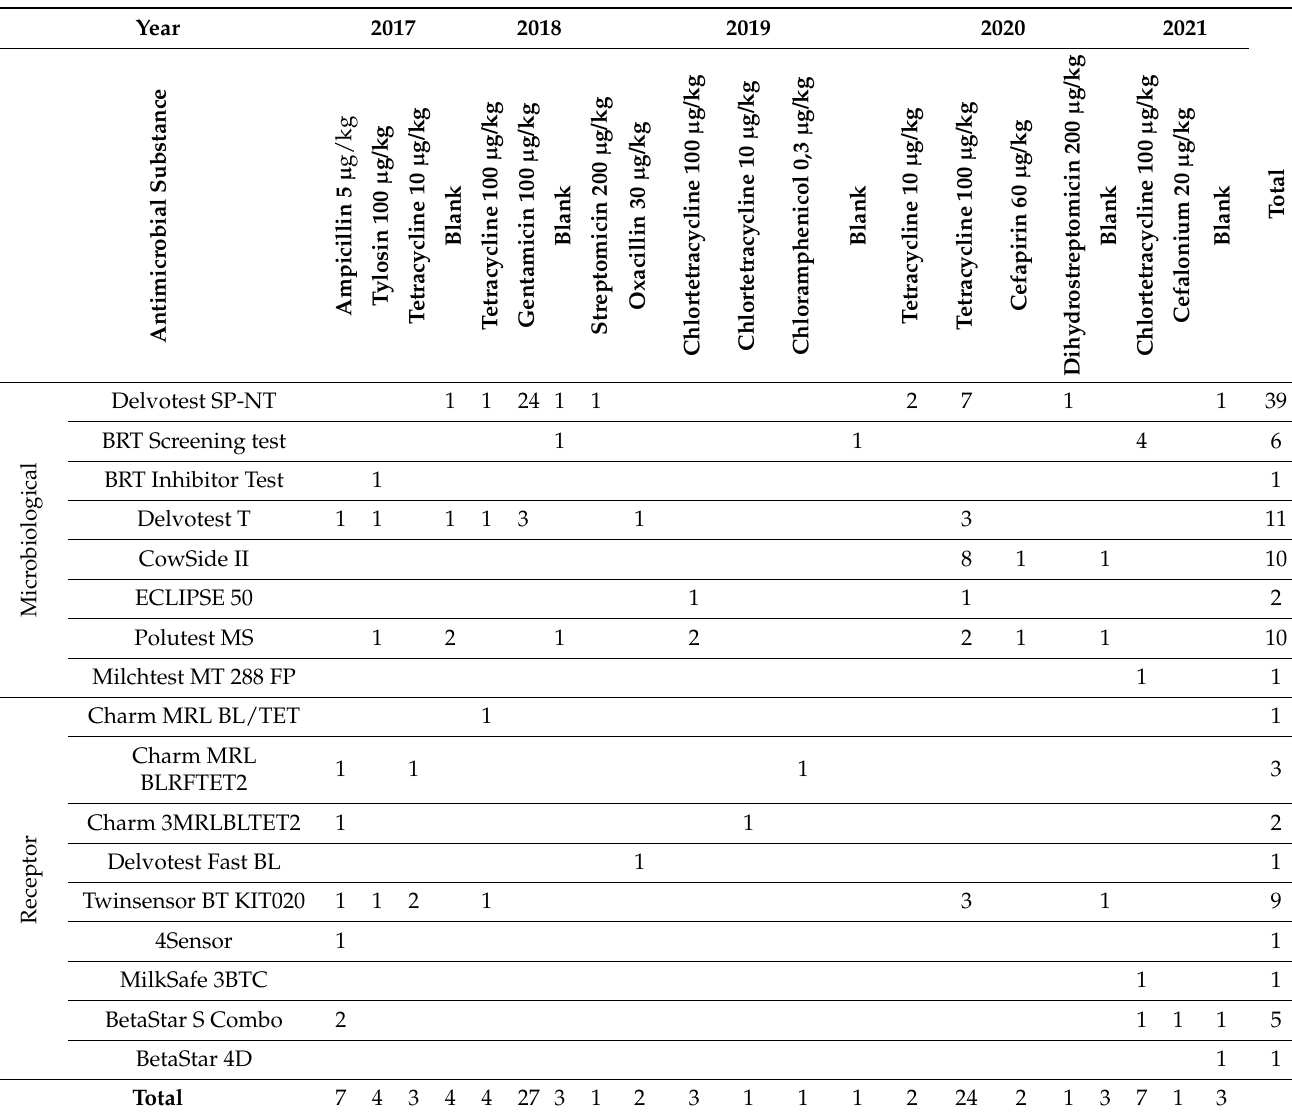
Table 3. Summary of non-compliant results for the tested